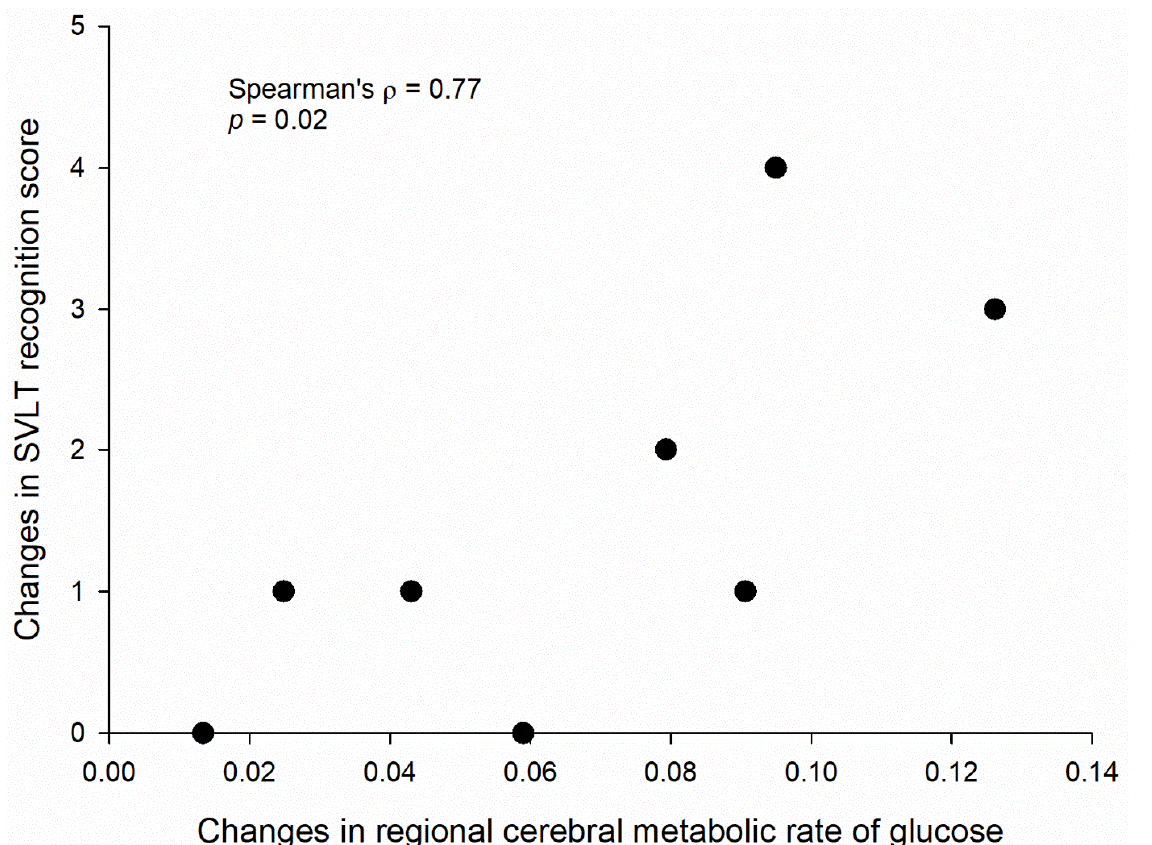
Figure 4. An association between changes in regional cerebral metabolic rate of glucose (rCMRglu) in the right hippocampus and changes of recognition memory on the Seoul Verbal Learning Test (SVLT) after transcranial focused ultrasound to the right hippocampus in patients with Alzheimer’s disease. Normalized rCMRglu was calculated as a ratio to global glucose metabolism.